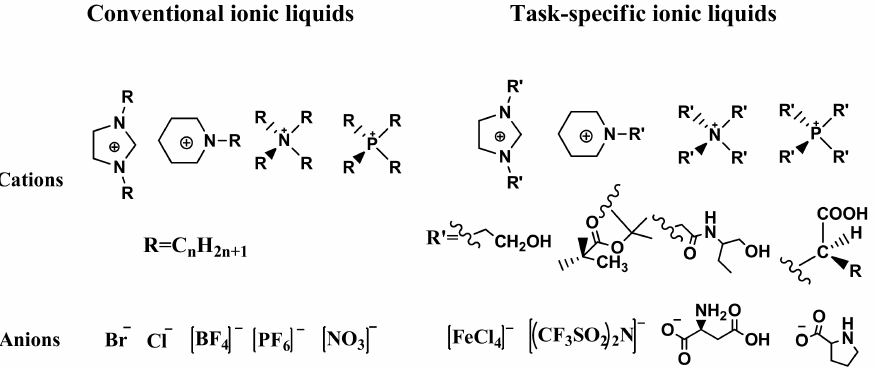
Figure 7. Structures of typical conventional ILs and TSILs.